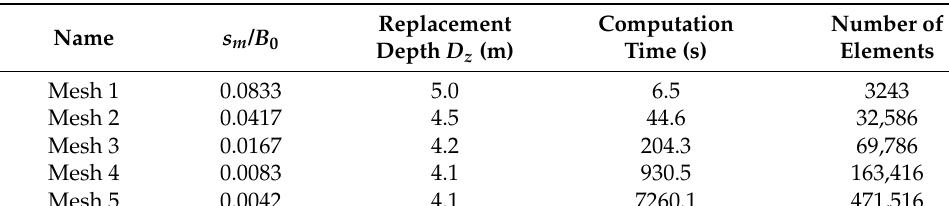
Table 3. Convergence study for mesh.